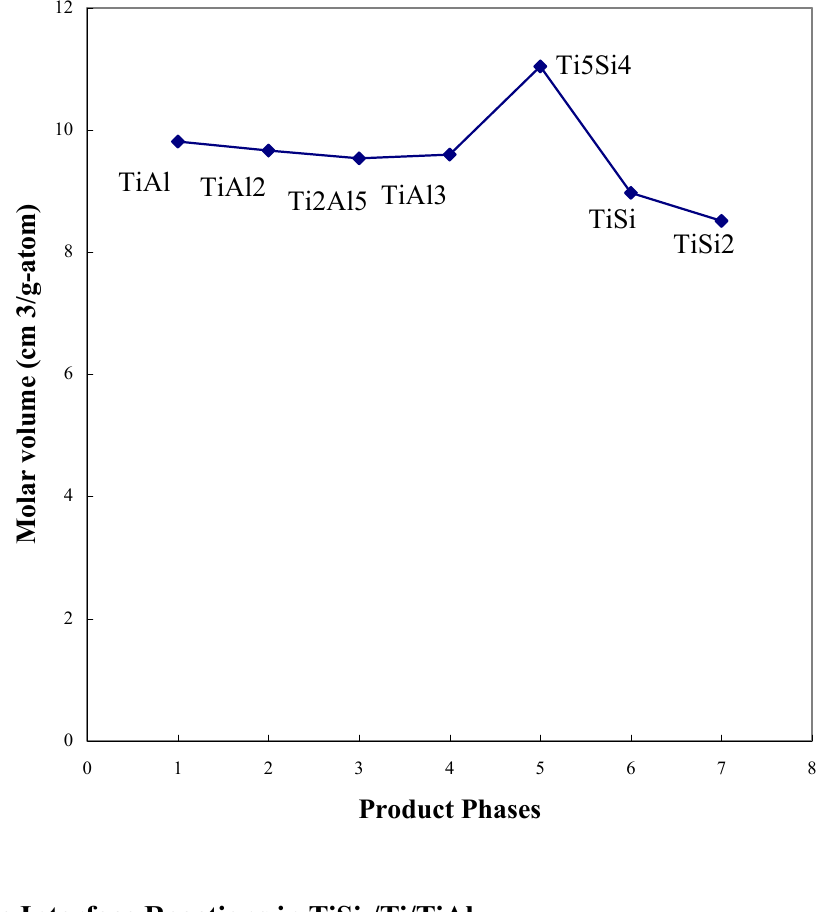
reaction couple 2